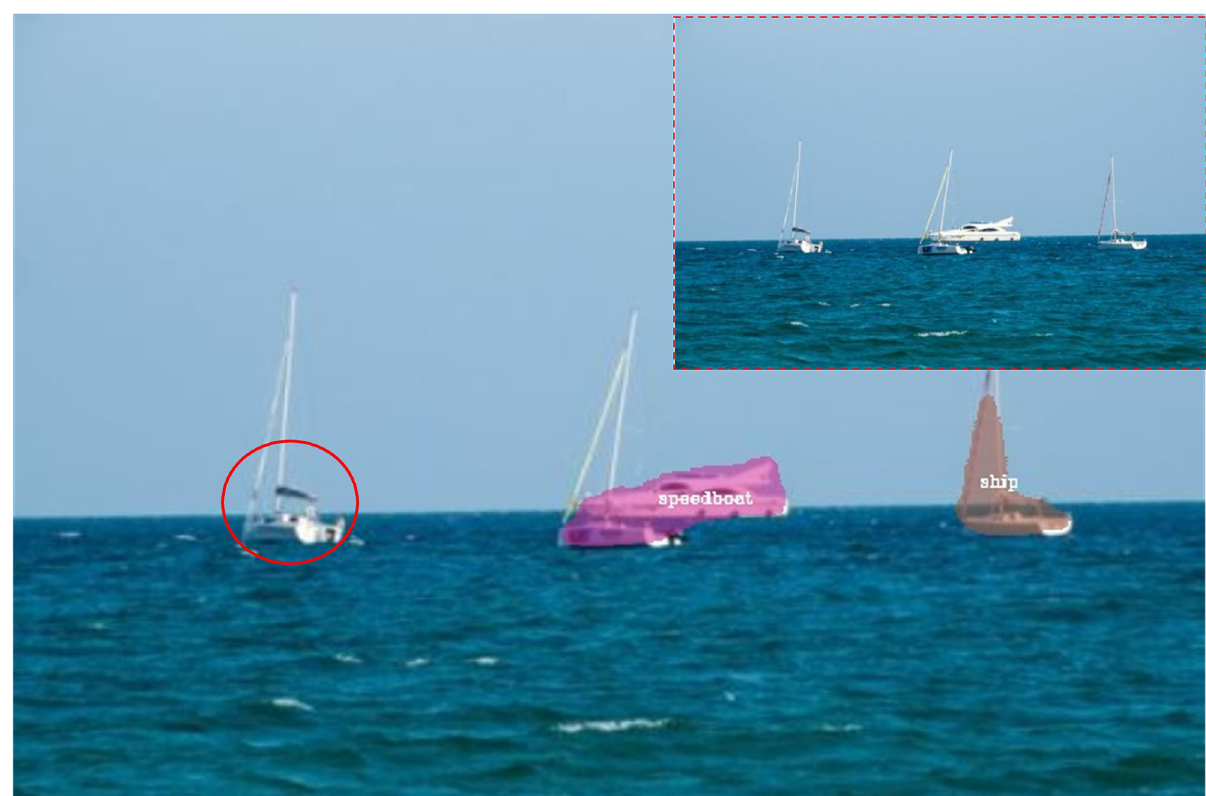
Fig 7. An example of a missed detection by the existing algorithms. The red circle represents the ship that should be detected but is not detected. Inset: the raw image.